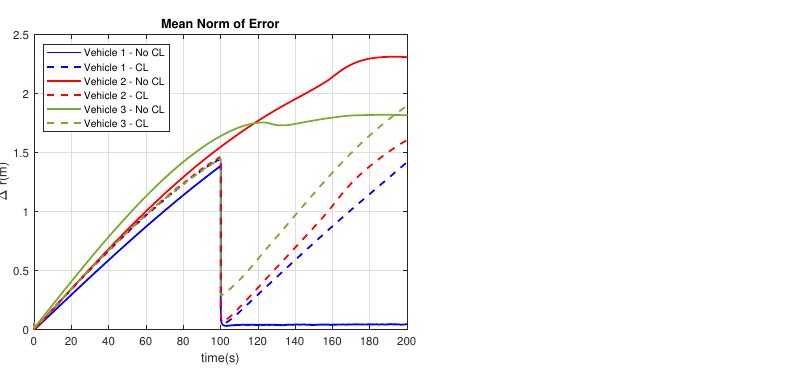
Figure 9. Comparison of error norms when vehicle 1 measures its own position for 1 s at the 100 s mark. Dashed lines indicate CL with relative position measurements for the first 100 s, and solid lines indicate no